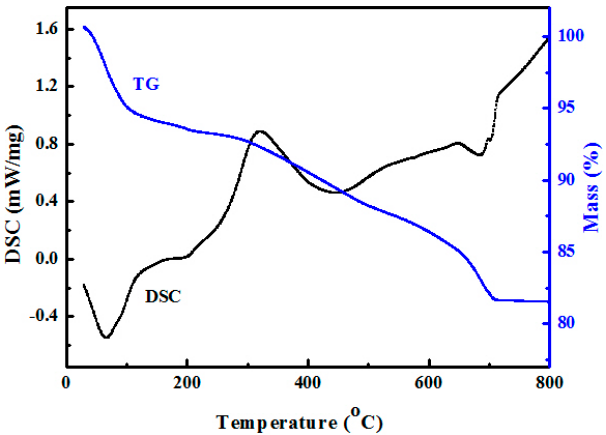
Figure 6. TG-DSC curves of the pristine palygorskite powders.